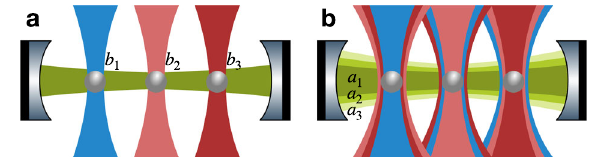
Fig. 1 Illustration of cooling collective Bogoluibov modes by applying multiple tweezers per particle. a Cooling of one Bogoliubov mode of three particles created by a combination of two-mode squeezing (blue tweezer) and beam-splitter (red tweezer) interactions. The relative strength of individual particle modes in the Bogoliubov modes is set by the relative intensity of the tweezers (light or dark red for particles b 2 and b 3 ). b Cooling of three Bogoliubov modes by coupling each to a different cavity mode (dark to light